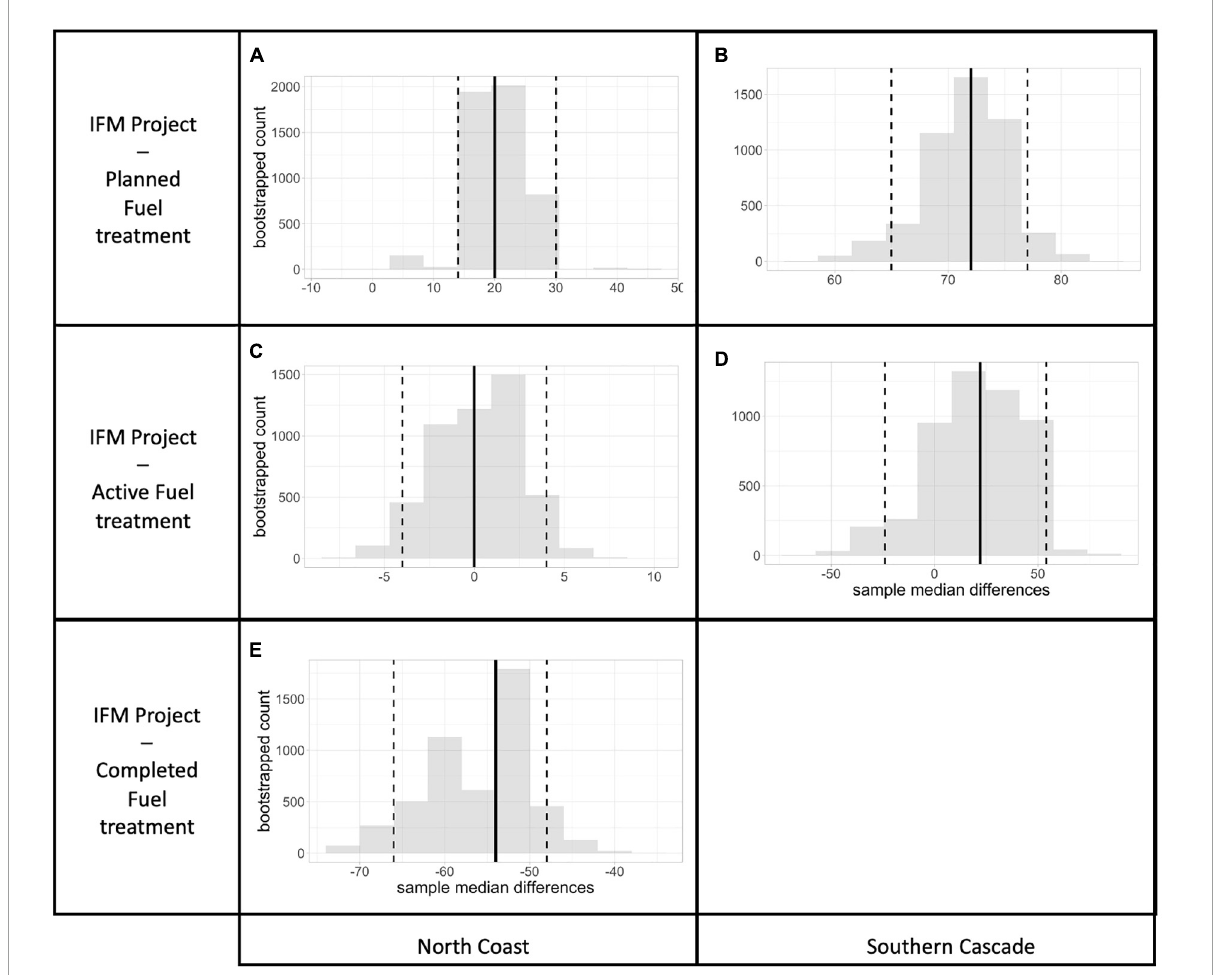
FIGURE4 Bootstrapped median differences in the trend of EVI between samples from offsets and fuel treatments between the North Coast (A,C,E) and Southern Cascade (B,D)